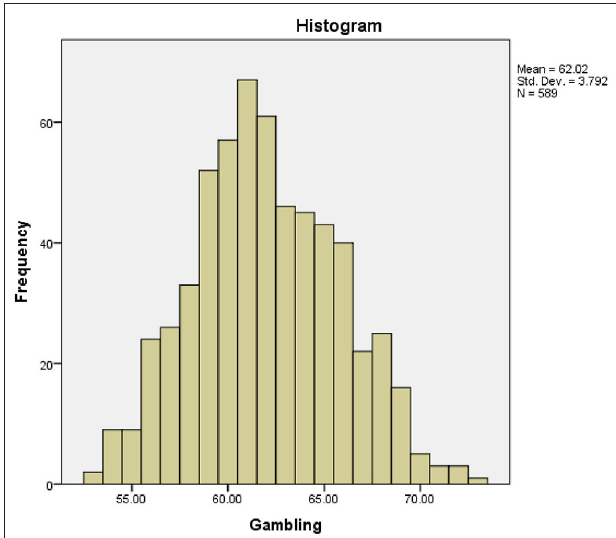
FIGURE 1 | Histogram showing data normality.